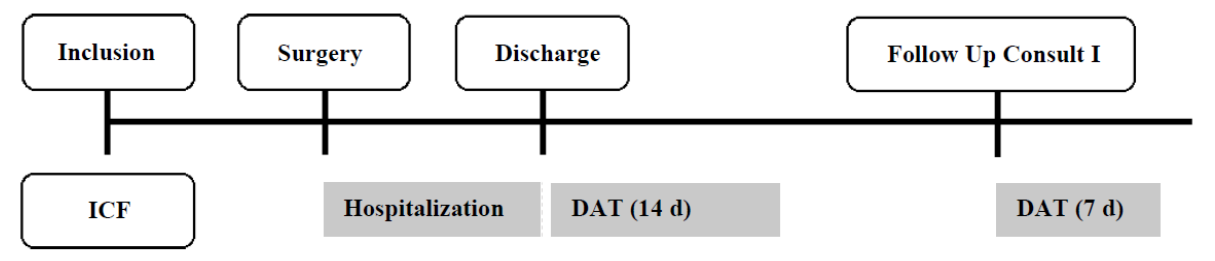
Figure 1. Timeline of the study design constructed in three evaluation time points: a preoperative inclusion, a 14-day Fitbit-wearing period after discharge, and a 7-day Fitbit-wearing period after a follow-up consult, 4 weeks after discharge. ICF: Informed Consent Form; DAT: Daily Activity